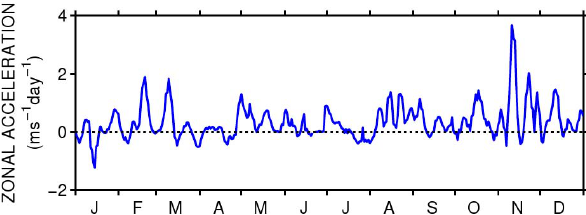
Fig. 15. Zonal acceleration (or body force per unit mass) obtained from UFKW measured by the Ascension Island meteor-radar at heights between 93.5 and 97.0km for the year 2006.